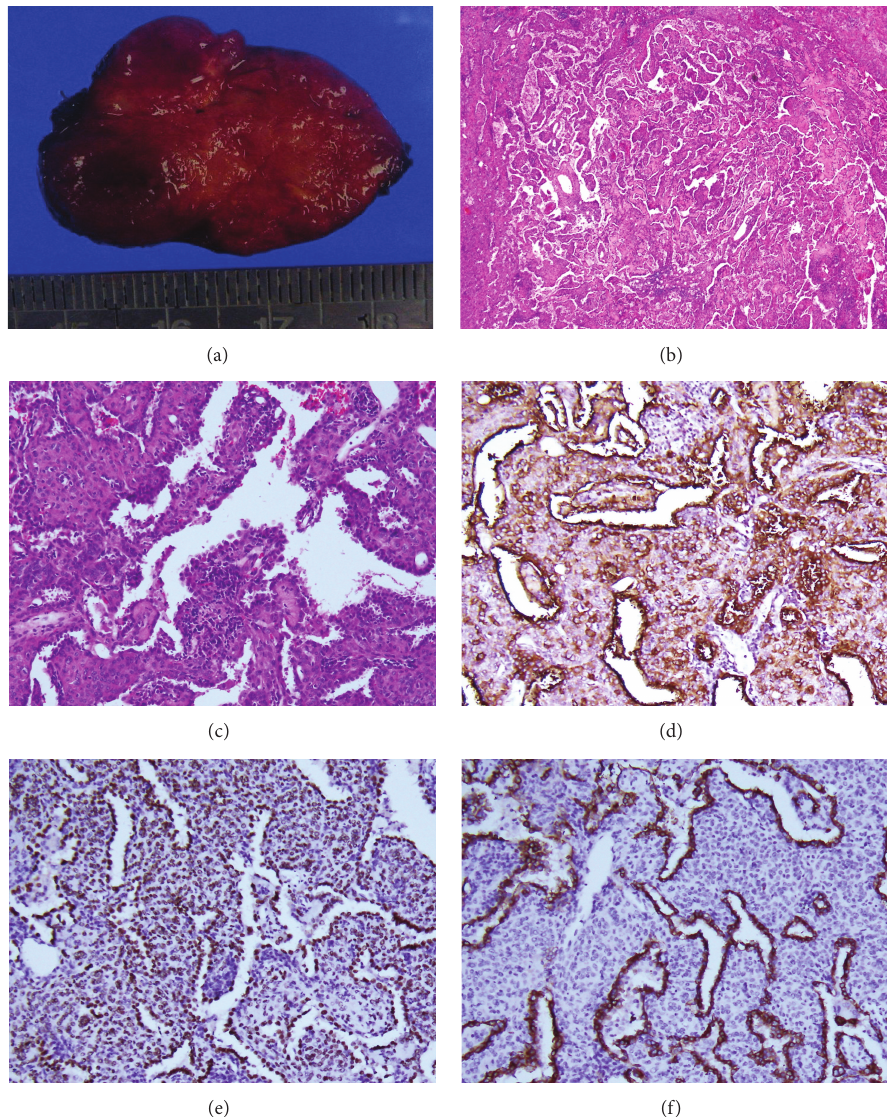
Figure 2: Histopathological analysis. (a) The gross specimen of the pulmonary hilar tumor is brownish and well circumscribed. (b) Microscopically, it shows a well-defined tumor composed of two cell types with round stromal cells and surface cells arranged in papillary, sclerotic, solid, and hemorrhagic pattern. Round cells are small with centrally located round to oval bland nuclei. Cuboidal surface cells are morphologicallyresemblingtypeIIpneumocyte.Lymphoplasmacyticinfiltrate,xanthomacells,hemosiderin,andcalcificationareseen(H&E stain, × 200). (c) In high power view, papillary configuration is revealed, formed by cuboidal surface cells and round stromal cells (H&E stain, × 400). (d) Photomicrographs show EMA and (e) TTF-1 are positive for both surface cells and stromal cells. (f) Cytokeratin is positive for surface cells and negative for stromal cells. Taken together, sclerosing hemangioma is